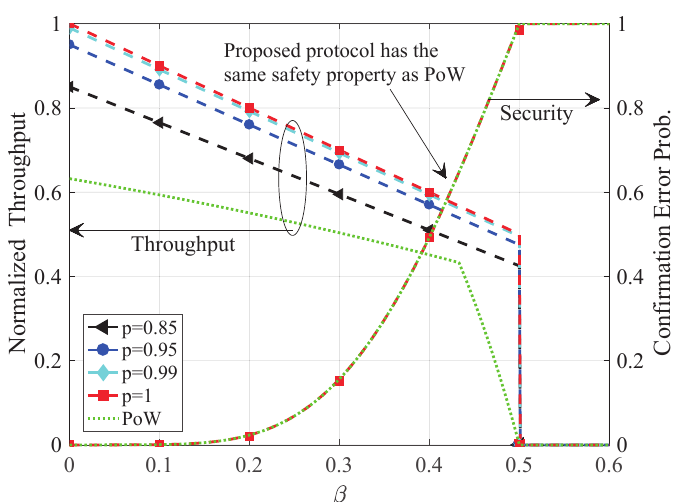
Figure 5. Comparison of the proposed protocol and PoW regarding throughput and safety.